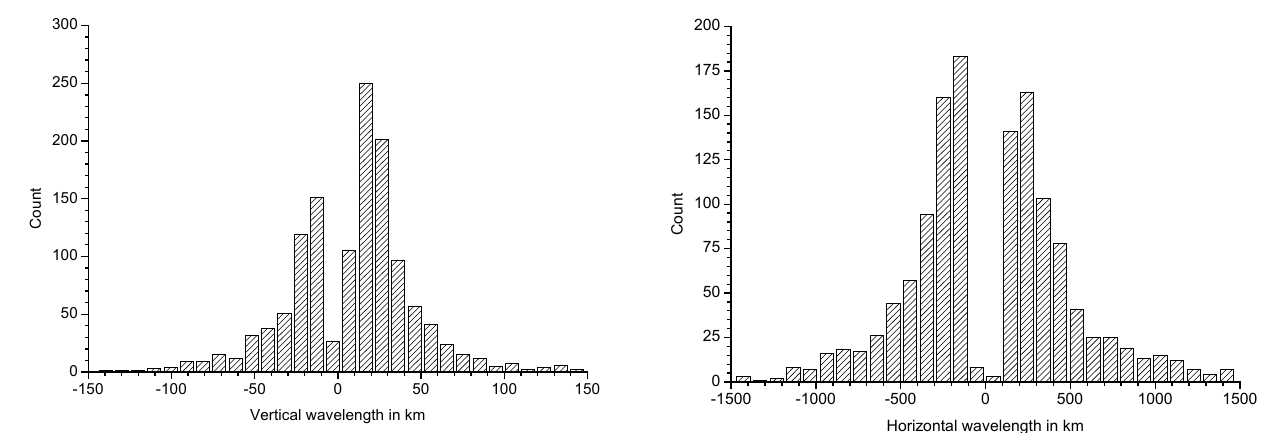
Fig. 4. Histograms of vertical (left panel) and horizontal (right panel) IGW wavelength. Figure 4: Histograms of vertical (left panel) and horizontal (right panel) IGW wavelength. IGW is then calculated. The altitude area, in which the cal- robust least-squares fitting and the hypothesis of linear re- culated horizontal wavelengths do not deviate more than the gression. Finally, the dispersion relation is checked, i.e. it is r.m.s. deviation from their mean value, is accepted as the spa- tested whether the IGW phase velocity satisfies the following tial area where the wave is present. A vertical IGW struc- expression (Gavrilov and Medvedev, ture check is applied similarly. For each altitude layer h i the mean values of phase and altitude are calculated, from which the vertical phase dependence is constructed, again using a